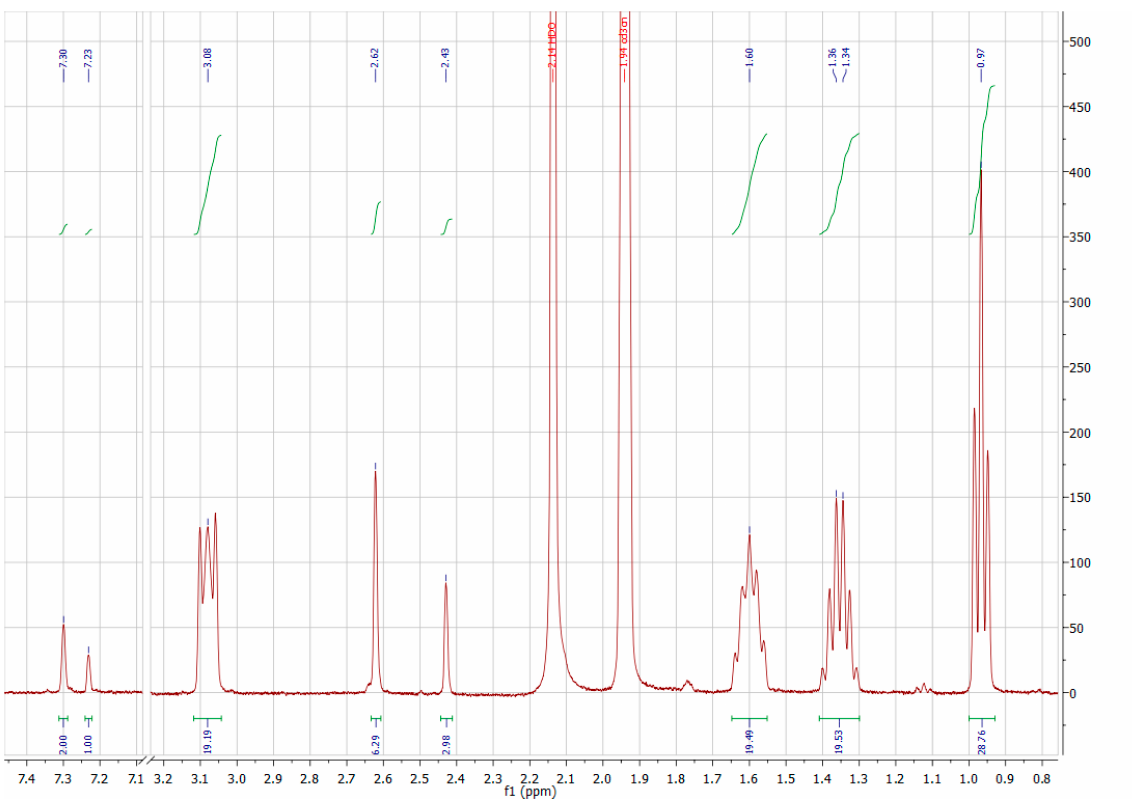
Figure A6. NMR Spectrum (400 MHz) of ( L4 ) in d6-DMSO.